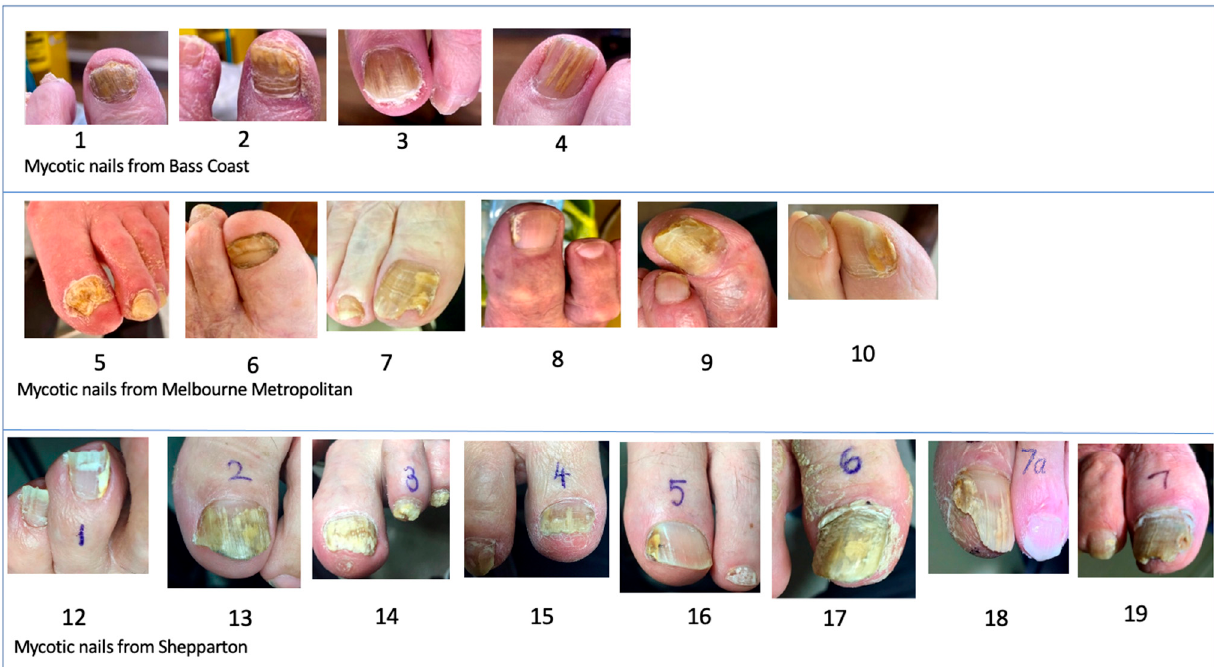
Figure 1. Images of 18 toenails clinically diagnosed as mycotic. Numbers drawn on the toes were solely for the purpose of identification by the contributing podiatrist. Missing numbers 11 and 20 were normal control nails .